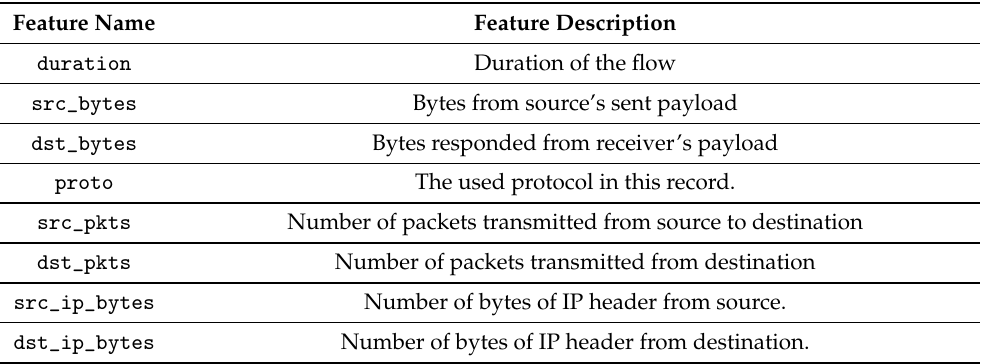
Table 3. The chosen set of features from the original